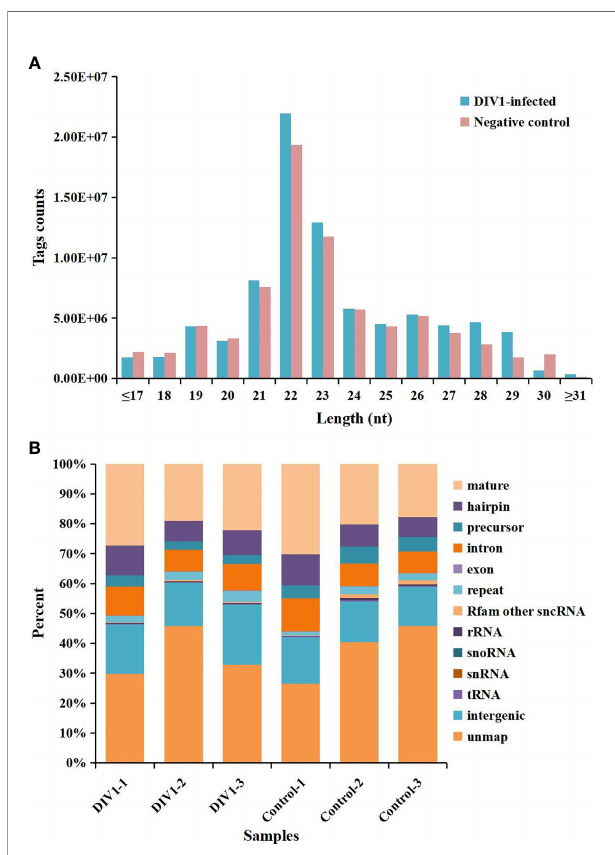
FIGURE 5 | Length distribution, abundance, and composition of small RNA libraries of DIV1-infected and non-infected Marsupenaeus japonicus intestine. (A) Length distribution and abundance of small RNAs from the intestine of the DIV1-infected group and negative control group. The x-axis indicates the length of small RNAs, and the y-axis indicates the tag counts. (B) Composition of RNAs in each small RNA library. The x-axis indicates the different samples, and the y-axis indicates the percentage of RNAs. DIV1, decapod iridescent virus